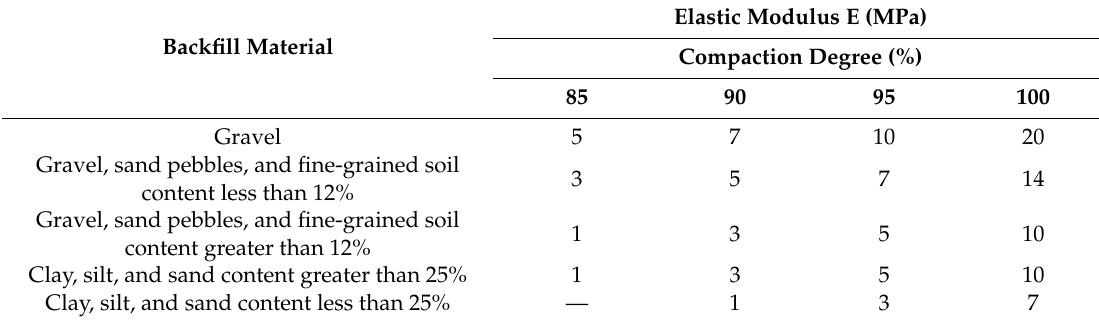
Table 5. Relationship between the compaction degree and the elastic modulus of the backfill.